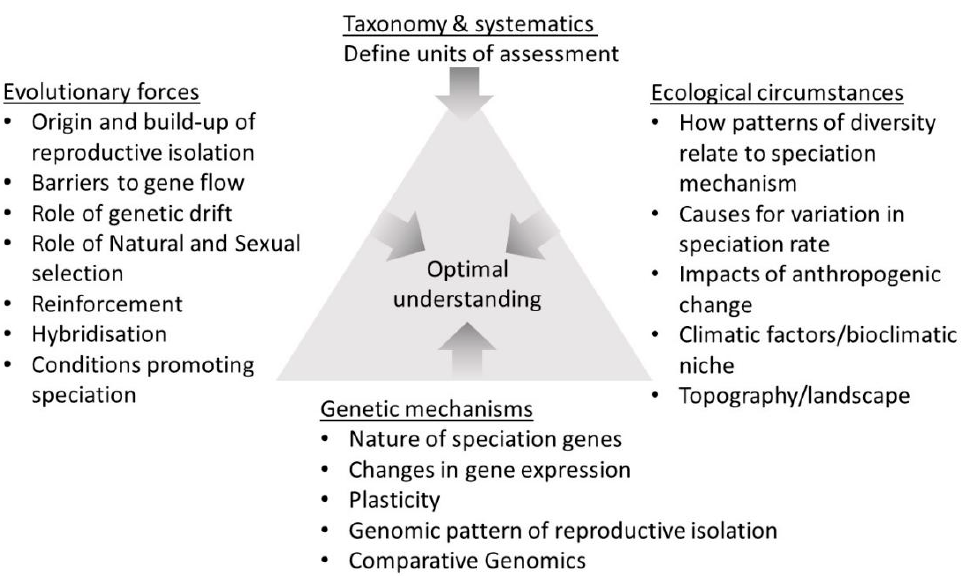
Figure 7. The different aspects contributing to speciation, modified after Butlin et al., 2012 [124]. Figure 7. The di ff erent aspects contributing to speciation, modified after Butlin et al., 2012